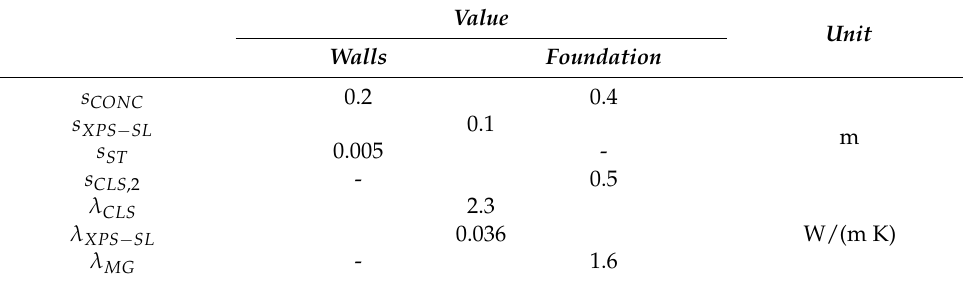
Table 4. Structural and thermal parameters of digester walls and foundation.